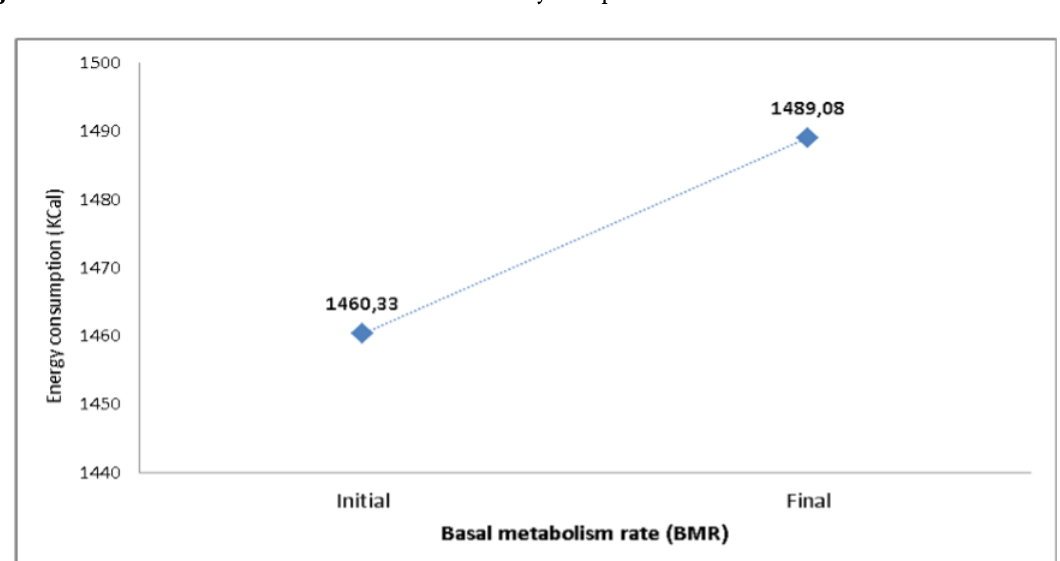
Figure 2. Effects of the cardio program on energy consumption